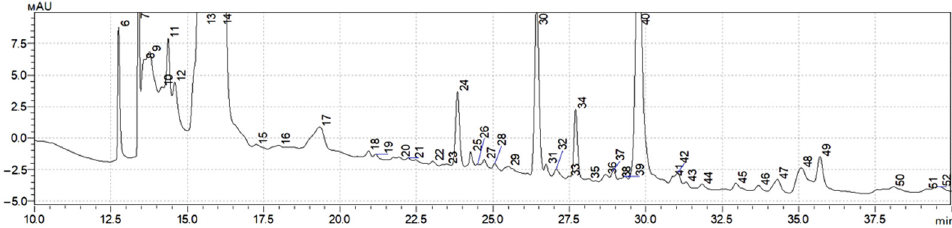
Figure 2. HPLC of the main polyphenols in Amelanchier ovalis : peak 24 is p-hydroxybenzoic acid; peak 34 is protocatechuic acid.